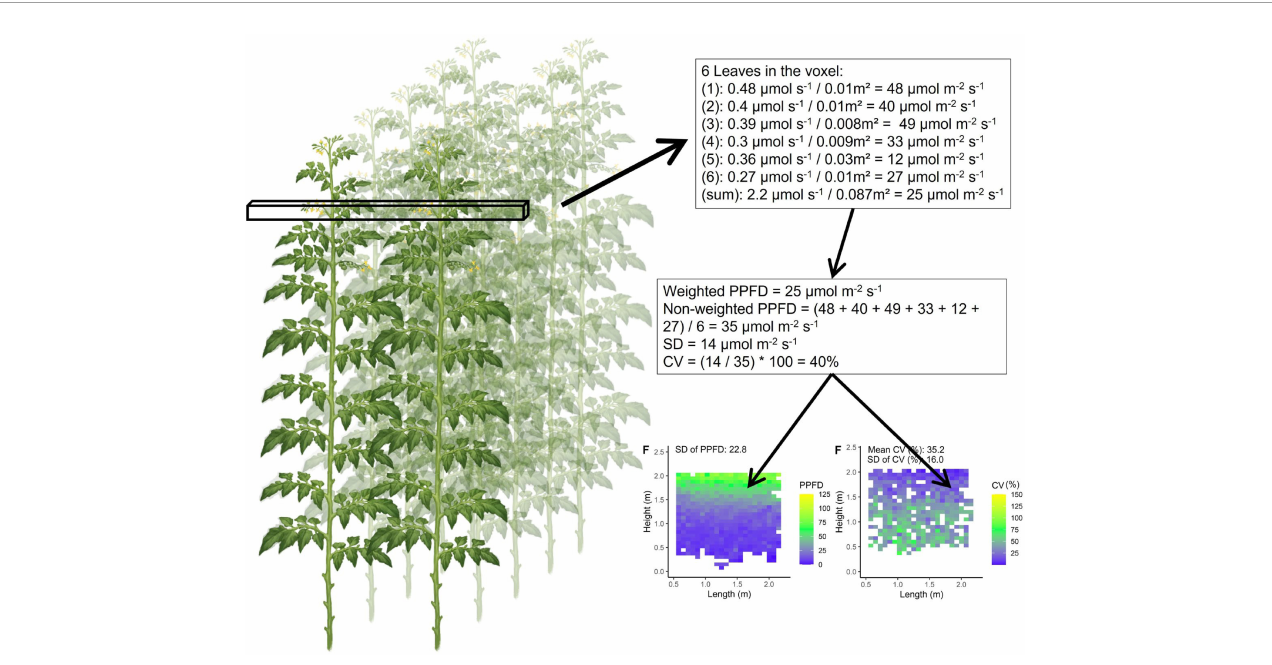
FIGURE 3 Calculation of the coef fi cient of variation (CV) and mean lea fl et absorbed PPFD within one voxel (perpendicular to the plant row) of the tomato plant canopy. Each voxel had the dimensions of 7.5 cm width and length and a depth reaching across four double rows (8 plants). As a hypothetical example calculated values are shown. Subsequently two fi gures are produced to visualise the PPFD of each voxel (voxels perpendicular to the rows) in the canopy and the coef fi cient of variation within each